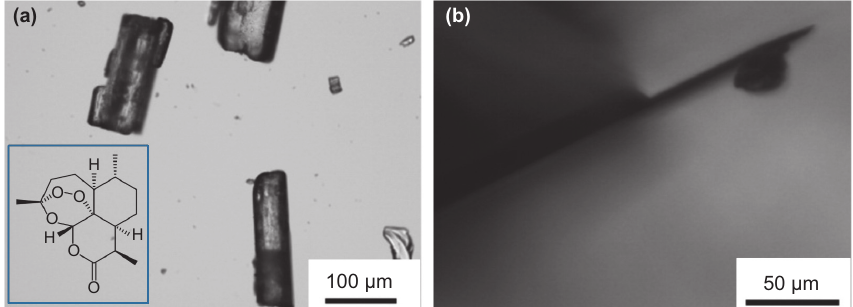
Figure 1. (a) Optical micrograph of several artemisinin crystals spread on glass slides. The inset shows the molecular structure of artemisinin. (b) Optical microscopy side view of a tipless AFM cantilever with an irregular shaped artemisinin crystal glued close to the triangular end of the